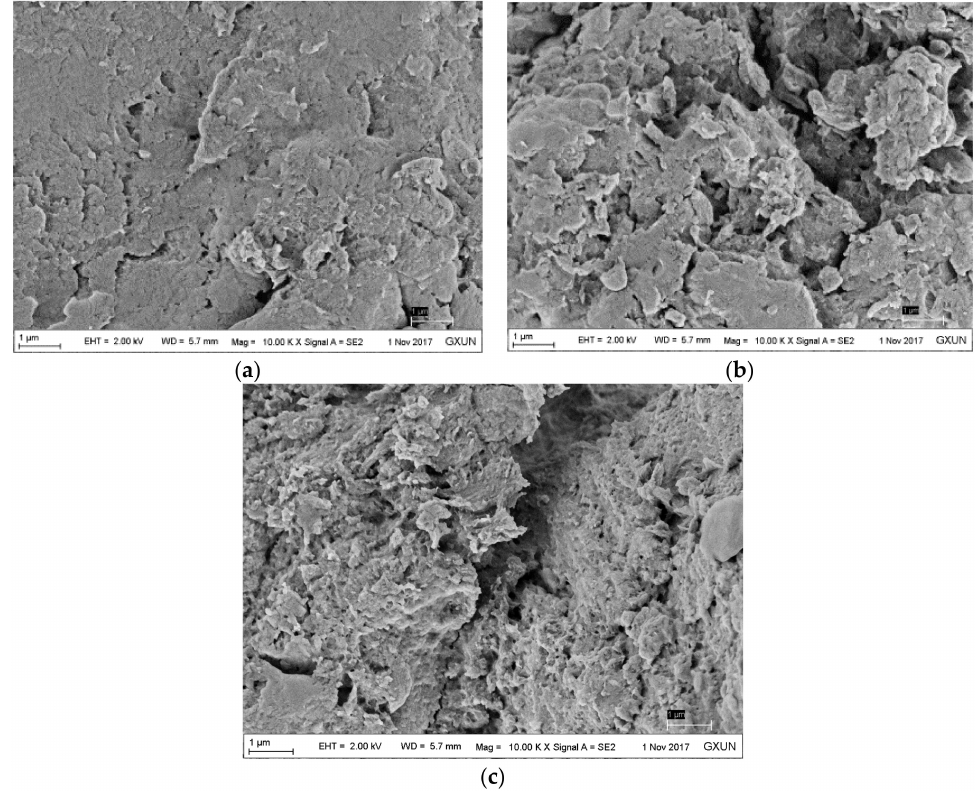
Figure 2. SEM images of BC ( a ), DABC ( b ), and HBP- g -BC ( c